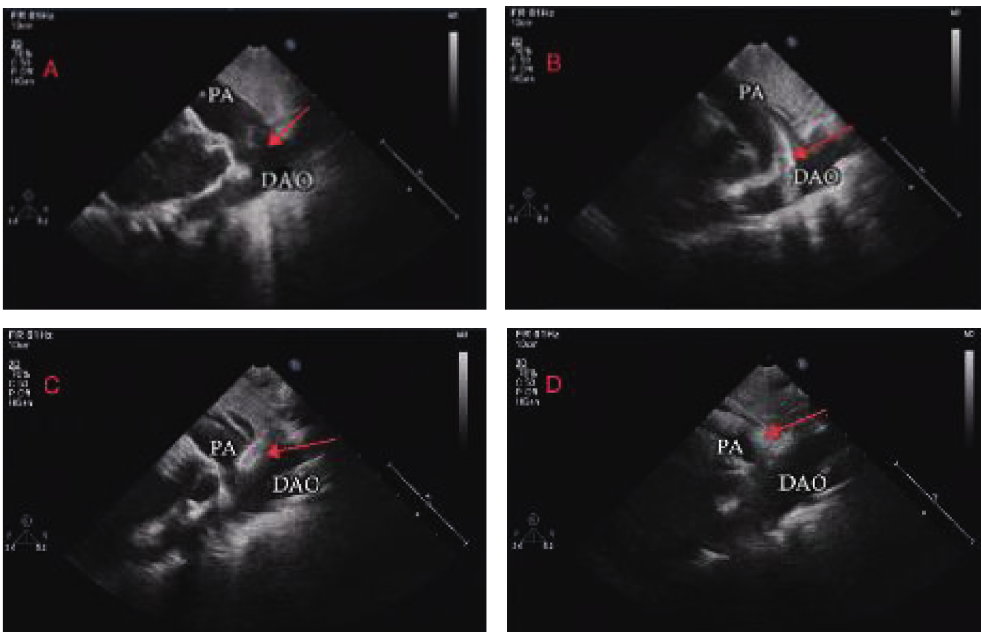
Figure 1: Transcatheter closure of a PDA under TTE guidance via femoral vein. (a) The PDA (arrow) was measured using the parasternal short-axis view. (b) The parasternal short-axis view showed that the guide wire (arrow) was located within the descending aorta. (c) Release of the aortal side disk of the occluder (arrow). (d) Release of the pulmonary side disk of the occluder (arrow). DAO � descending aorta; PA � pulmonary